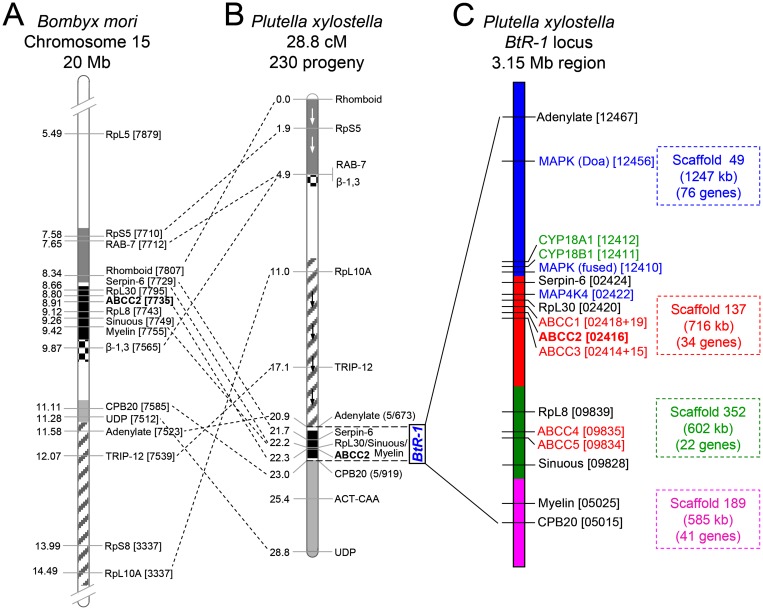
Assembly of the chromosomal region of the BtR-1 resistance locus in P. xylostella.(A) Schematic diagram of partially sequenced chromosome 15 from B. mori. (B) P. xylostella linkage map according to Baxter et al. [10]. Blocks of common genes are shaded and arrows depict inverted orientation in P. xylostella. The dotted lines show multiple chromosomal rearrangements, while maintaining genetic synteny. (C) Detailed genetic makeup of the BtR-1 resistance locus. The four P. xylostella genome scaffolds in BtR-1 are distinguished by color and their information is also listed at the right side. The seven mapped genes were marked out in black (except PxABCC2 in red), all the five PxABCC genes in BtR-1 are denoted in red, three genes in the MAPK signaling pathway are labeled in blue, and two P450 genes are in green. B. mori and P. xylostella gene identifiers refer to the final four or five numbers (note underlining) of the Gene ID corresponding to each genome database (e.g., BGIBMGA007879-TA or Px012467).